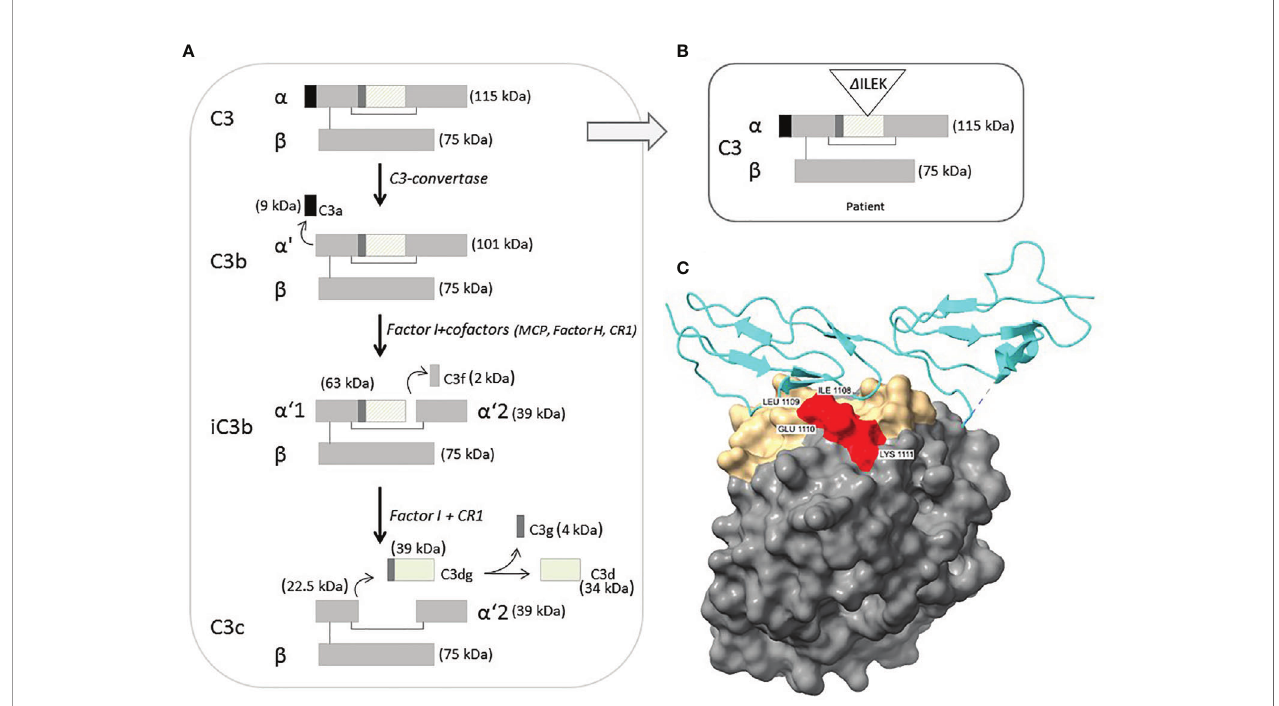
FIGURE 2 | (A) Schematicrepresentation of intact C3 structure, processing and regulation.The diagonal-line fi lledrectanglerepresents the TEDofC3. (B) Schematic representation of the position offour-residue deleted sequence ( D ILEK)within the TED domainofthe patient ’ s C3 alpha chain. (C) Modelling of the C3b (TED domain)-Factor H complex (from PDB 3OXU) (19),using the UCSF ChimeraX tool. C3b isshownin solvent-excluded molecular surface representation,and FactorH (P08603) incyan ribbons. All C3b interfacial aminoacidsare colored gold, whilethe p.1008-1111 (ILEK)mutant region iscolored red. As clearly demonstrated,amino acids ILEK are an integral part ofthe C3b-Factor H